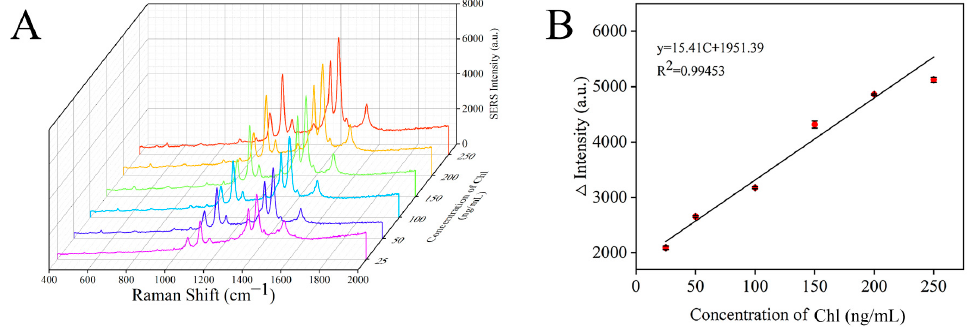
Figure 9. SERS spectra of different concentrations of chlorpyrifos ( A ) and the correlation between Raman intensity and chlorpyrifos concentration ( B ).